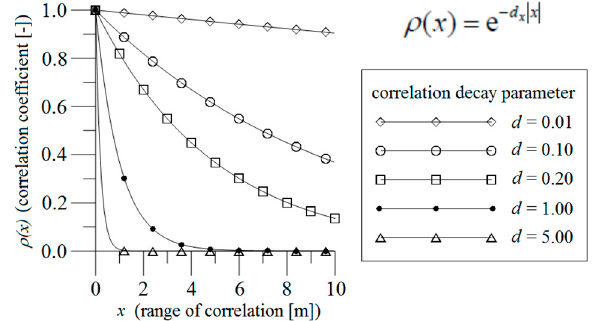
Figure 2. Correlation range for different damping parameters d . The random field applied in the FE model of the subsoil block is based on the previous truncated Gaussian variable of Young’s modulus E ( µ E = 28, 000 kPa, σ E = 7000 kPa, t = 4). A number of 200 three-dimensional Gaussian fields of n re = 1000 points are generated, corresponding to each of the five correlation decay parameter values, directly implemented in the FE model. The number is limited to 200 samples only, as the time required to generate the fields, to create FE models incorporating these data, to conduct the numerical calculations, and to analyse the results is extremely significant. A graphical example of a generated highly correlated random field ( d = 0.01 m − 1 ) is shown in Figure 3.